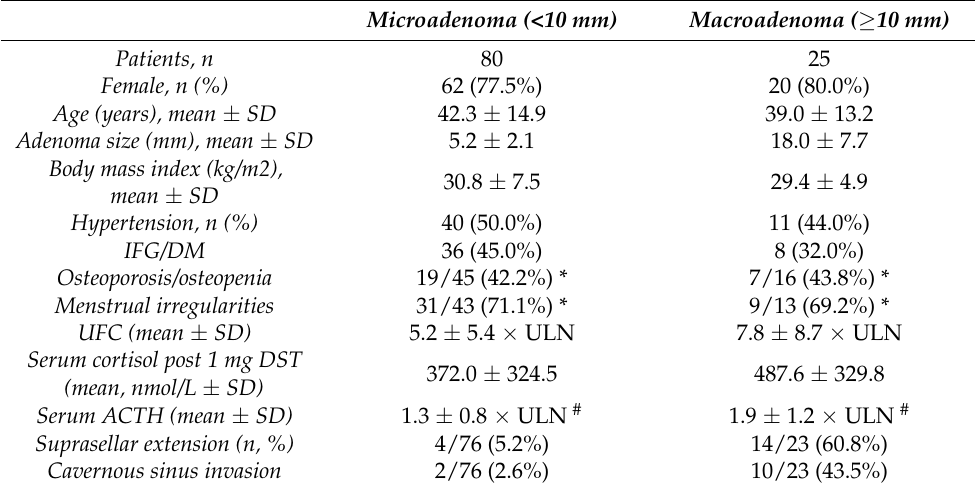
Table 1. Baseline characteristics. Baseline characteristics and comorbidities of patients by each category. * As data on signs and symptoms were not available for all patients, data presented as number of patients with the specific feature of all relevant patients with available data. # p <